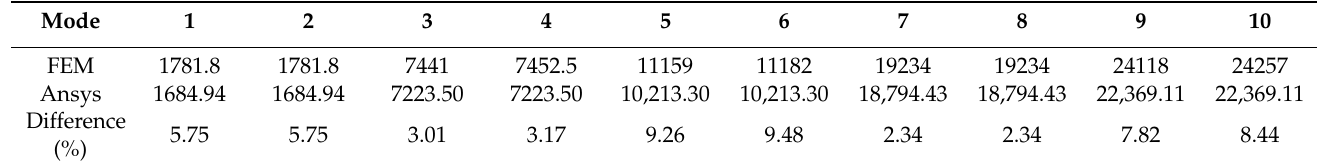
Table 3. Natural Frequencies, ω ( rad / s ) , of Two Euler–Bernoulli Beams Analysis with Hinged